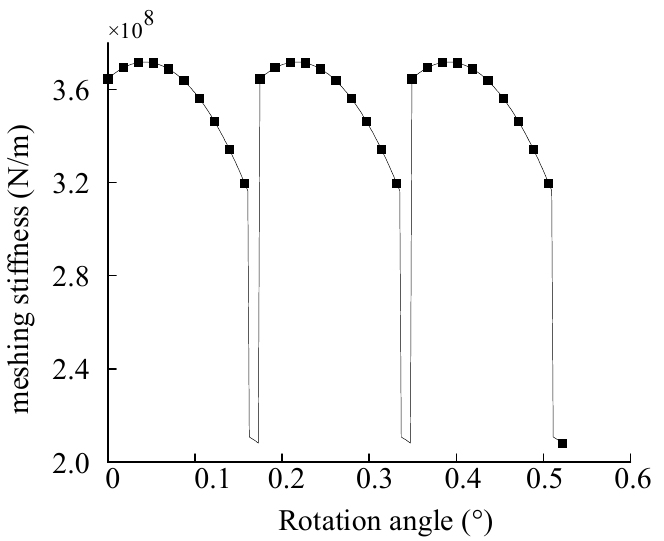
Figure 5. The meshing stiffness of inner gear ring and planetary gear. Figure 5 . The meshing stiffness of inner gear ring and planetary gear